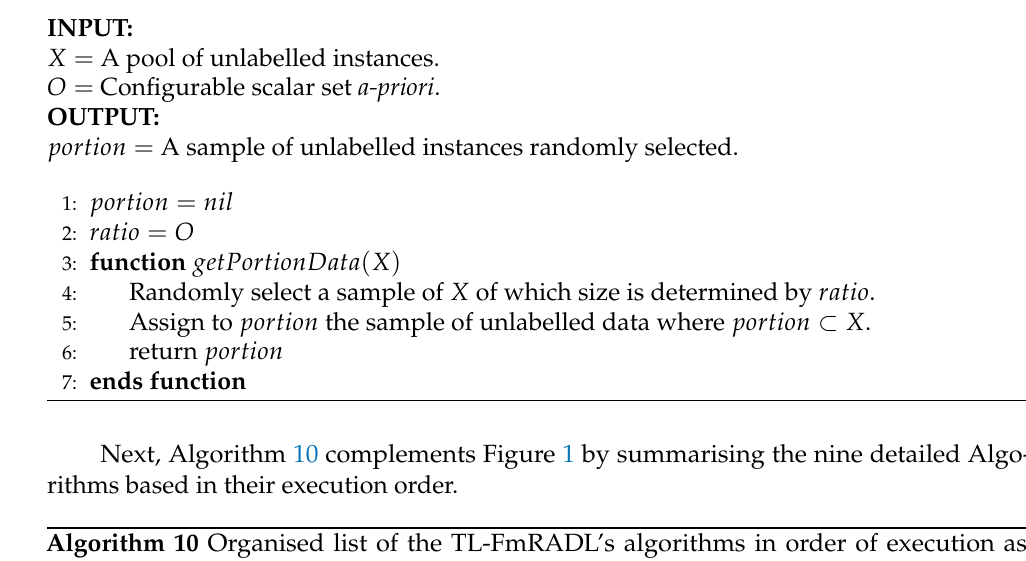
Algorithm 9 Selection of a portion of incoming data to serve as a sample of unseen data to test the accuracy of new AR models.